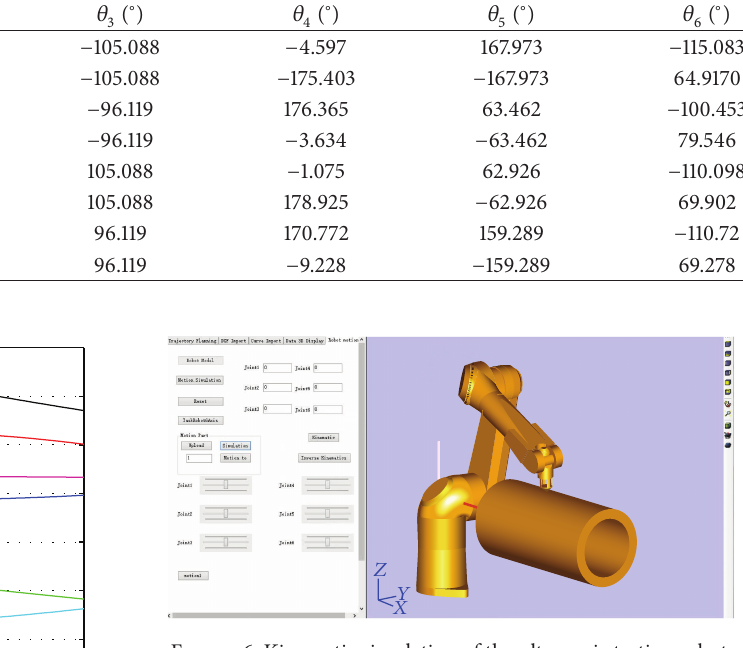
Figure 6: Kinematic simulation of the ultrasonic testing robot.